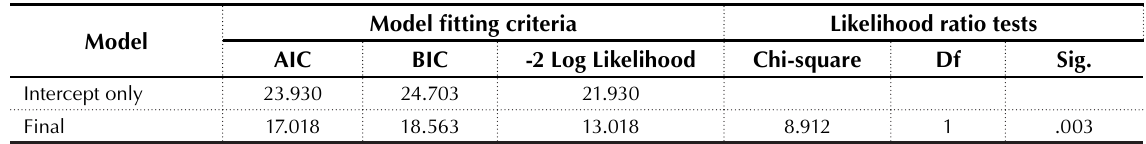
Table 22. Model fitting information of profitability and sustainability of AIRCABS